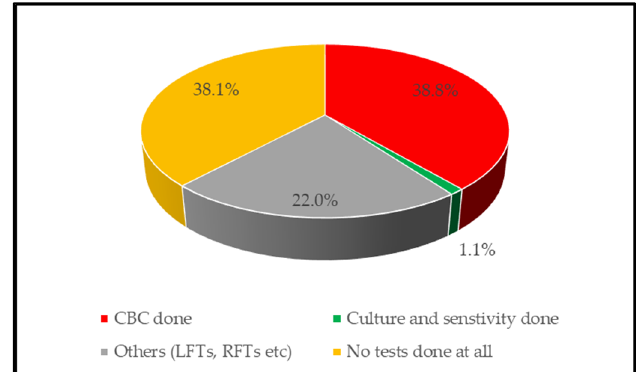
Figure 4. Laboratory testing rates for the nine health facilities ( n = 885).